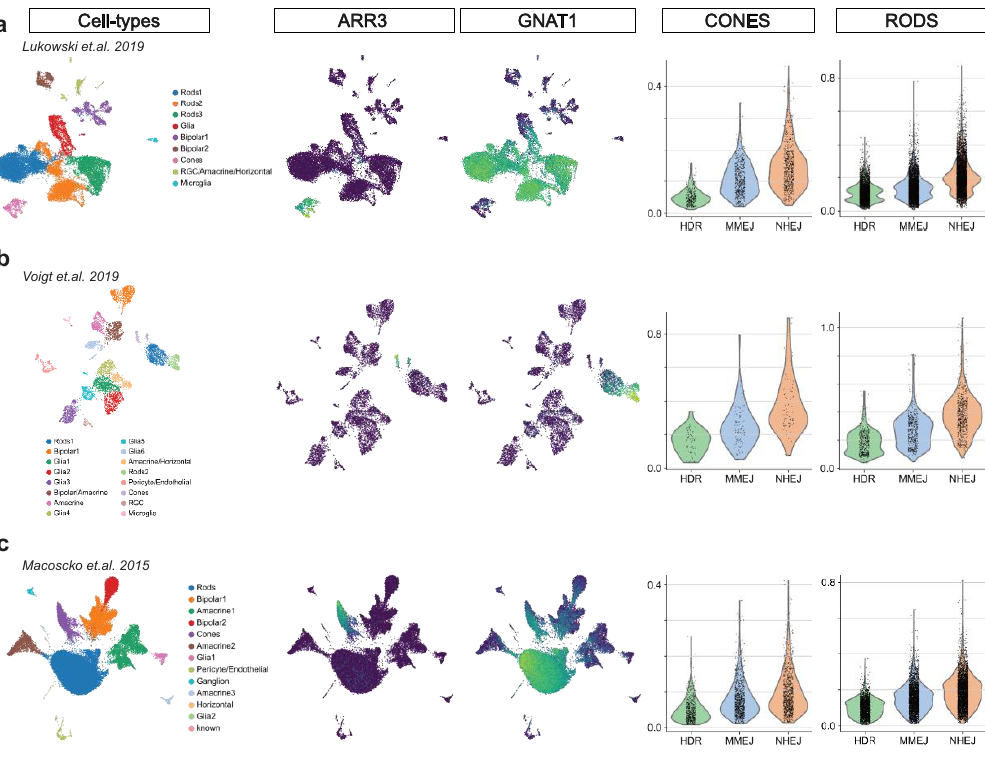
Figure A3. Mouse and human adult retina scRNA-seq. Three adult retina scRNA-seq dataset are analyzed in this figure: ( a , b ) human adult retina, ( c ) mouse adult retina. Each dataset is visualized in two-dimensional UMAP, colored by annotated clusters (cell types) and PR markers (ARR3 and GNAT1). Violin plots show DSB repair pathway scores in rods and cones.